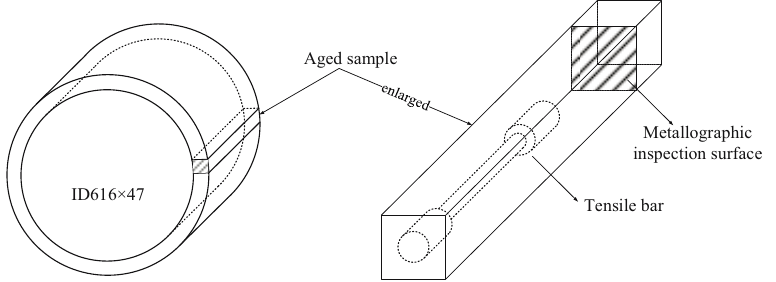
Figure 1: Schematic diagram of the test